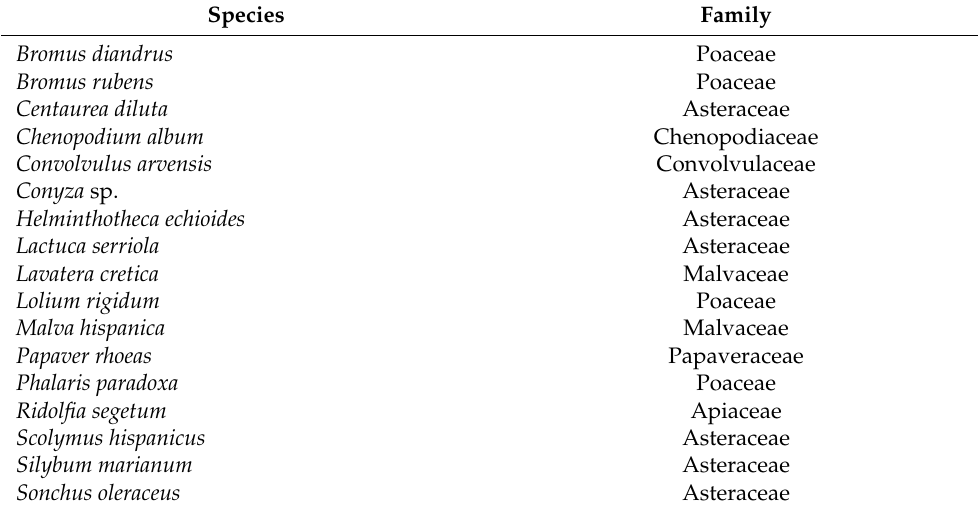
Figure 3. Abundance of unwanted species in the MFM, on each farm and at a general scale. Different letters (A, B, C) show significant differences in the analysis of variance obtained in the different margins through the LSD test ( p ≤ 0.05). Table 2. Spontaneous flora species found on the